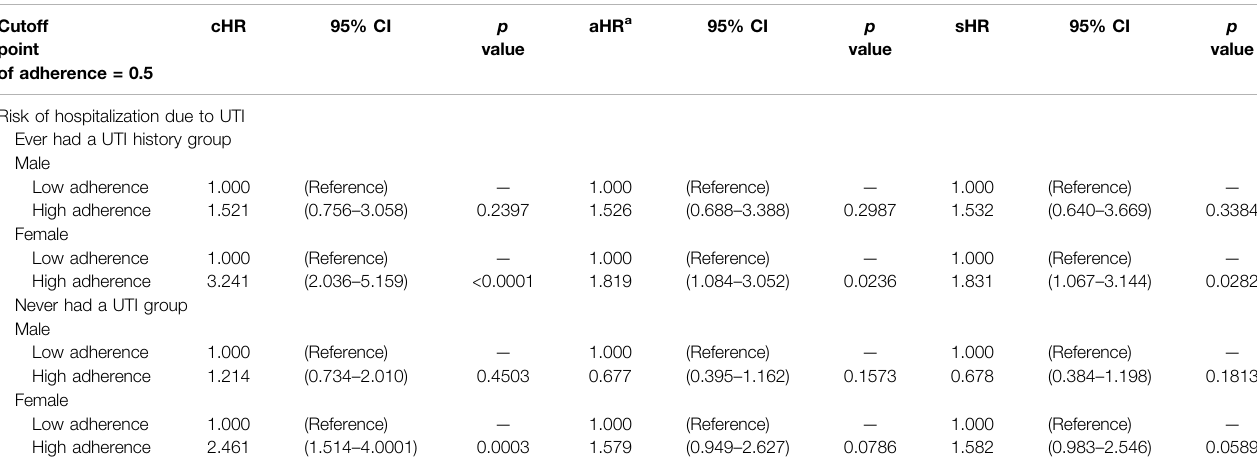
TABLE 4 | Risk of UTI (hospitalization) in sensitivity analysis of the cutoff point of adherence. Cutoff point of adherence =